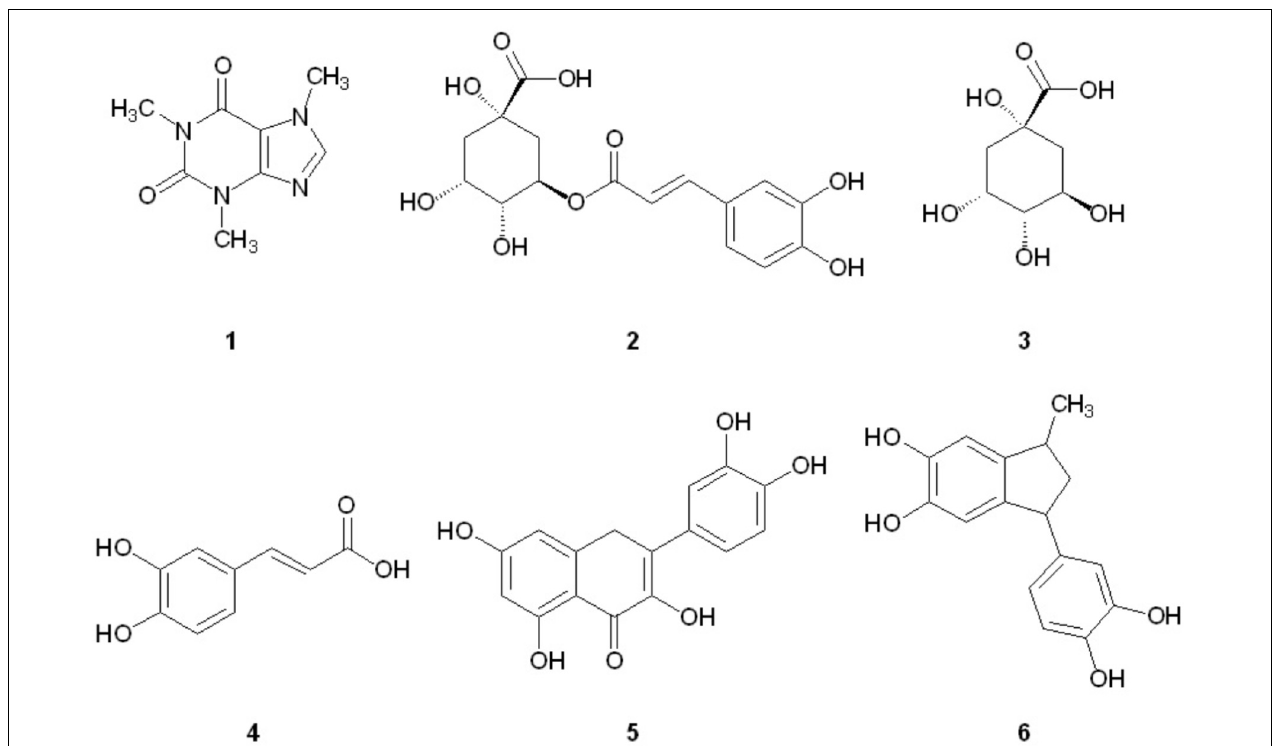
FIGURE 1 | Structures of coffee components investigated for aggregation inhibition